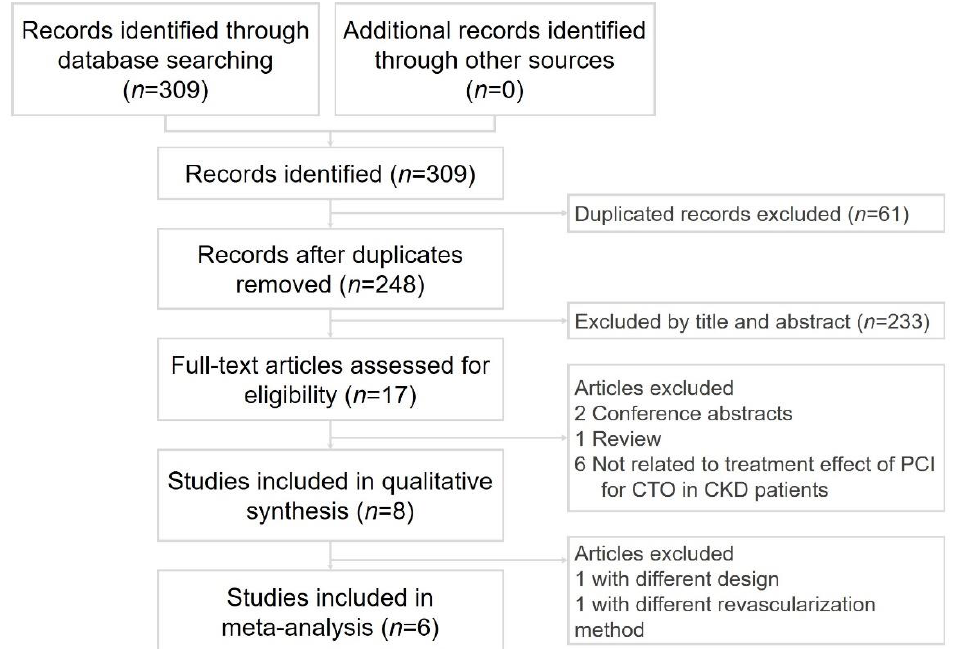
Figure 1. Flowchart of the selection strategy and inclusion and exclusion criteria for this meta-analysis. PCI, percutaneous coronary intervention; CTO, chronic total occlusion; CKD, chronic kidney disease.